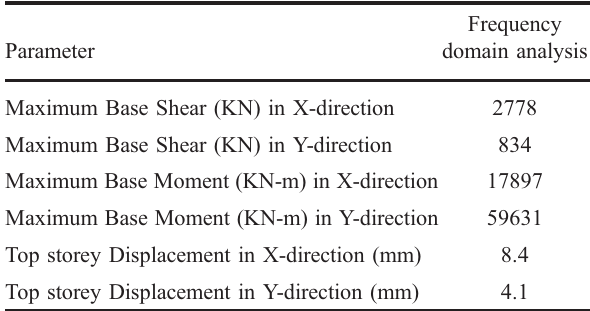
Table 5. Dynamic analysis results (fixed buildings)